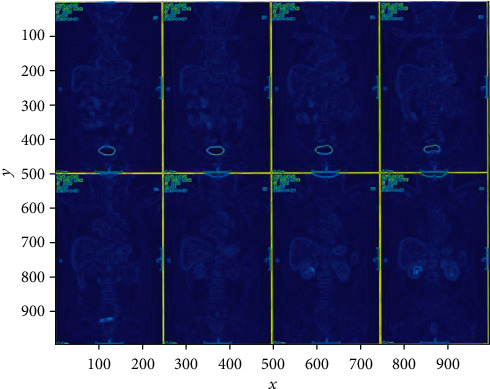
Plane display of pixel intensity in prostate cancer lesions.